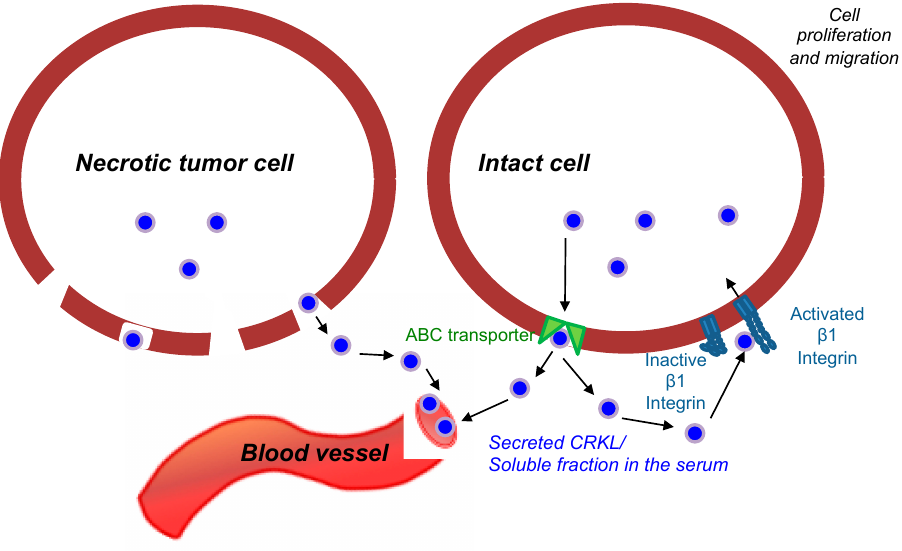
Figure 5. Schematic presentation of the proposed mechanisms of the presence of membranal and soluble Crk-like protein (CrkL) fractions in aggressive breast carcinoma (based on the data in Reference [11,19]).